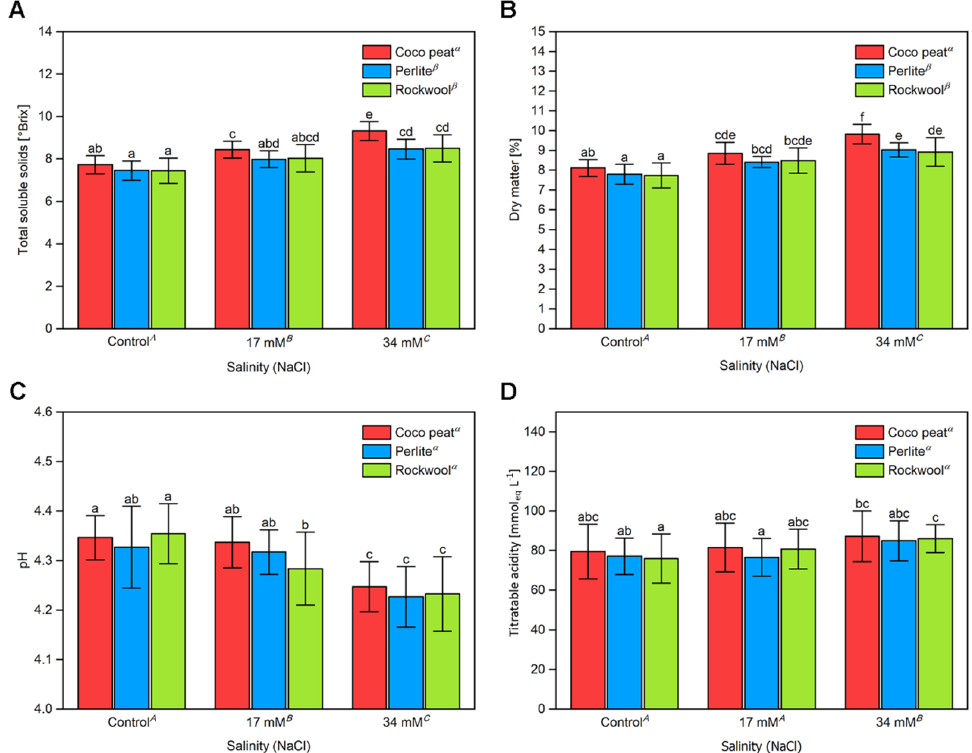
Figure 3. The total soluble solids content, titratable acidity and dry matter content of cherry tomato fruit grown in different substrates with increasing salinity. The average total solids content ( A ), dry matter content ( B ), pH ( C ) and titratable acidity ( D ) from five harvests between the 4 September and 17 October 2017 grown in coco peat, perlite and Rockwool at a sodium chloride content of 0, 17 and 34 mM in the nutrient solution. The mean and SD of the total soluble solids were calculated from four different grow bags on each grow table. Upper-case letters compare the salinity treatments; Greek letters compare different substrates, lower-case letters within the graph compare single mean values of the treatments. The raw data are available in Supplementary File S1.